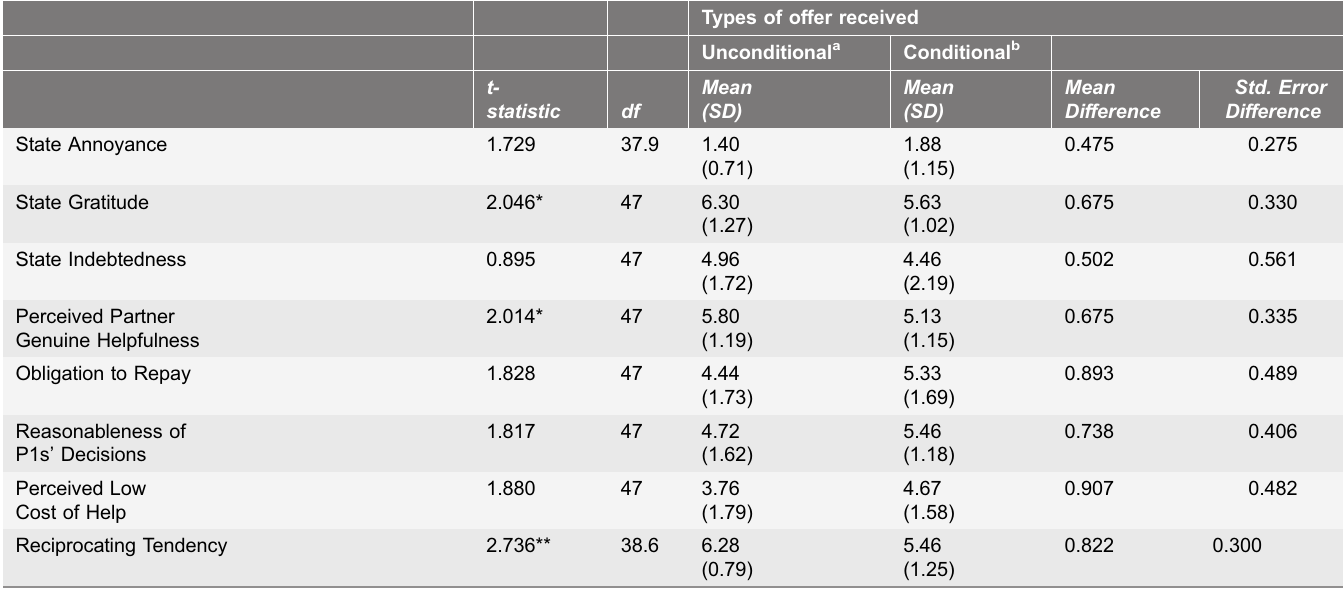
Table 1. Statistics for P2s’ post-offer ratings.